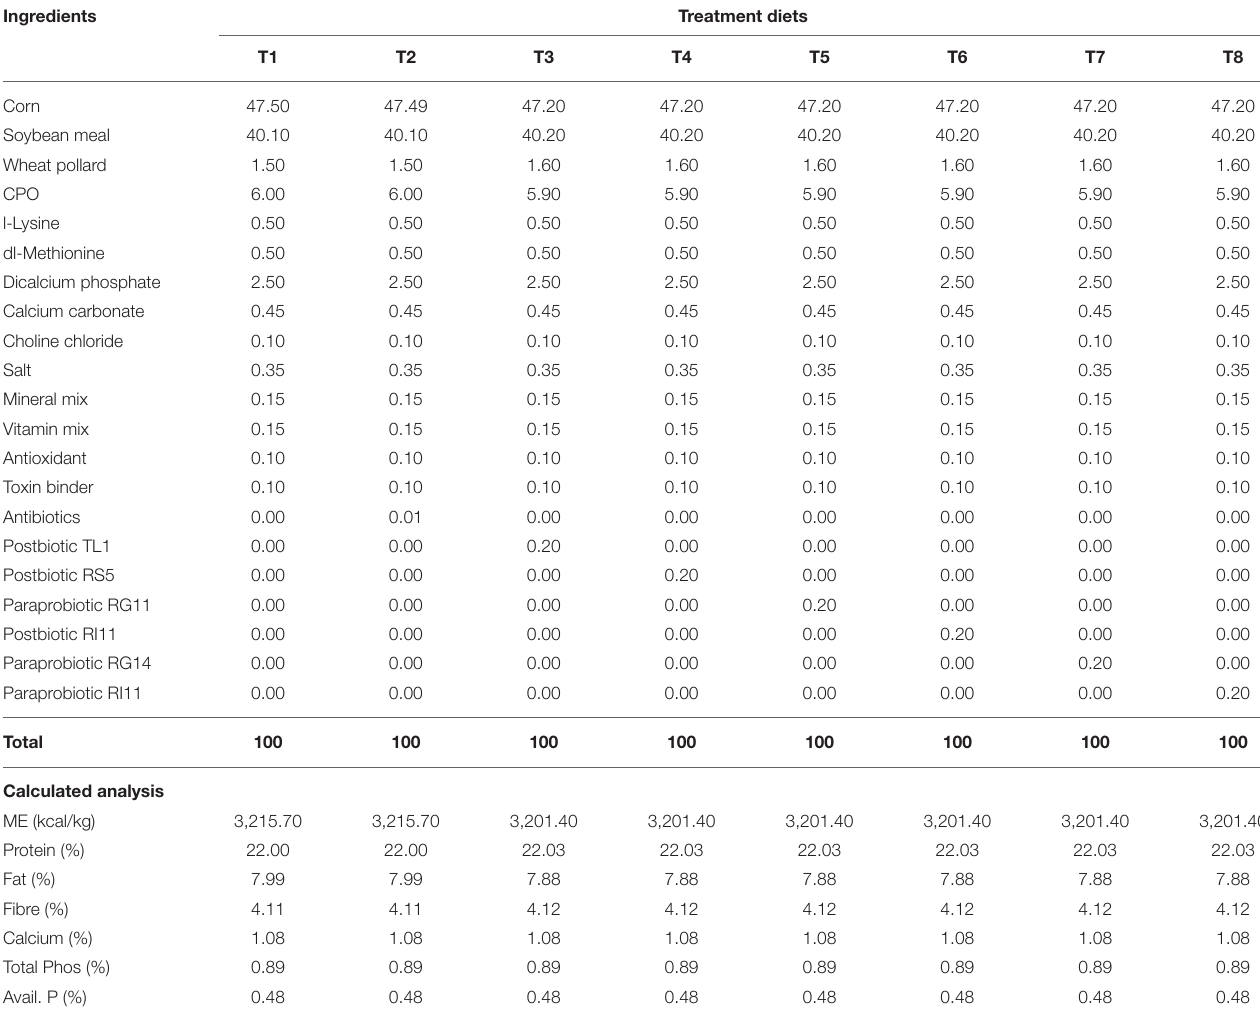
TABLE 1 | Nutrient composition of starter diets (days